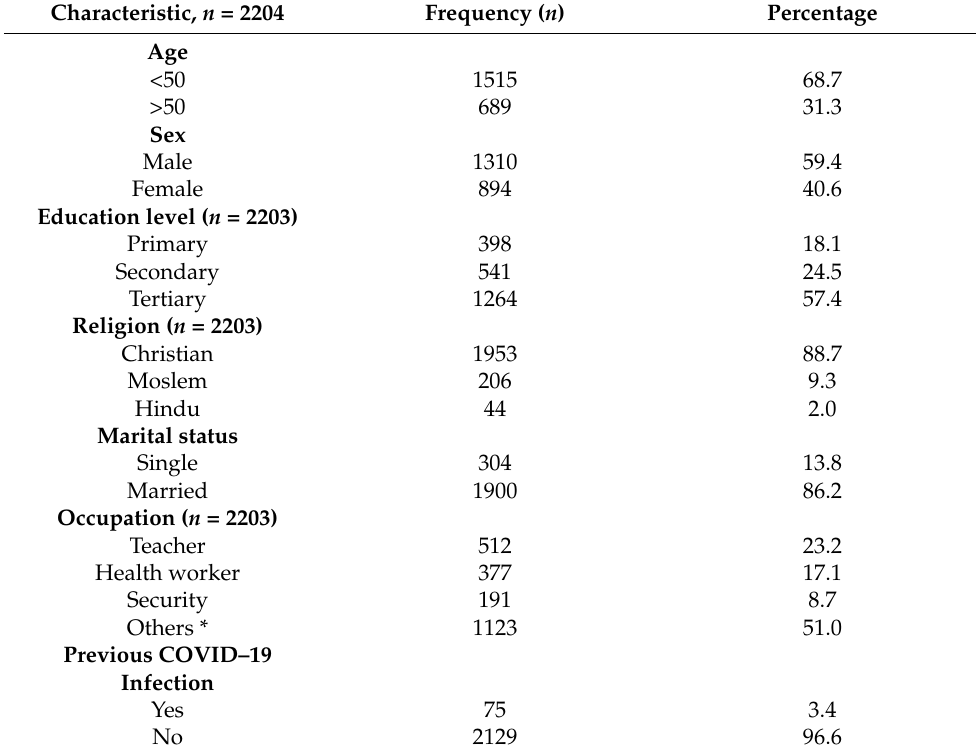
Table 1. Characteristics of study